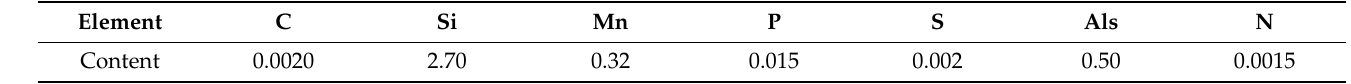
Table 1. Chemical composition of experimental raw materials